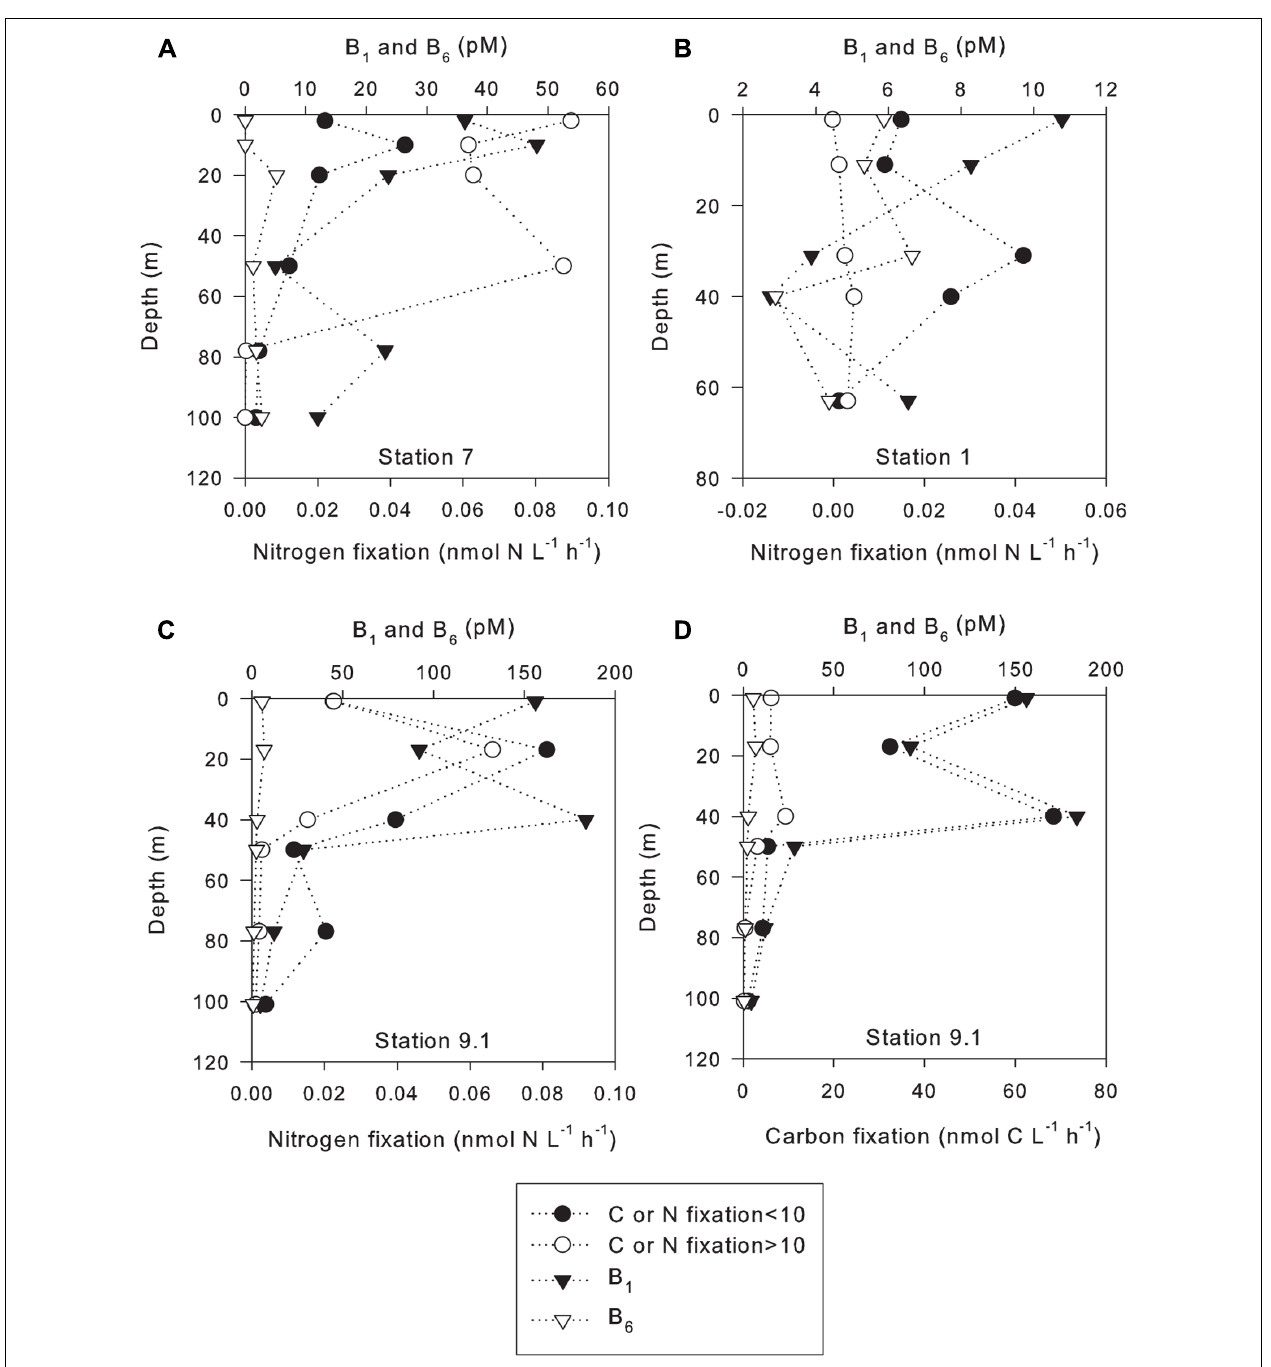
FIGURE 3 | Carbon and nitrogen fixation rates in the less than and greater than 10- μ m size classes with B vitamin depth profiles. (A) Station 7; (B) Station 1; (C) Station 9.1; (D) Station 9.1.